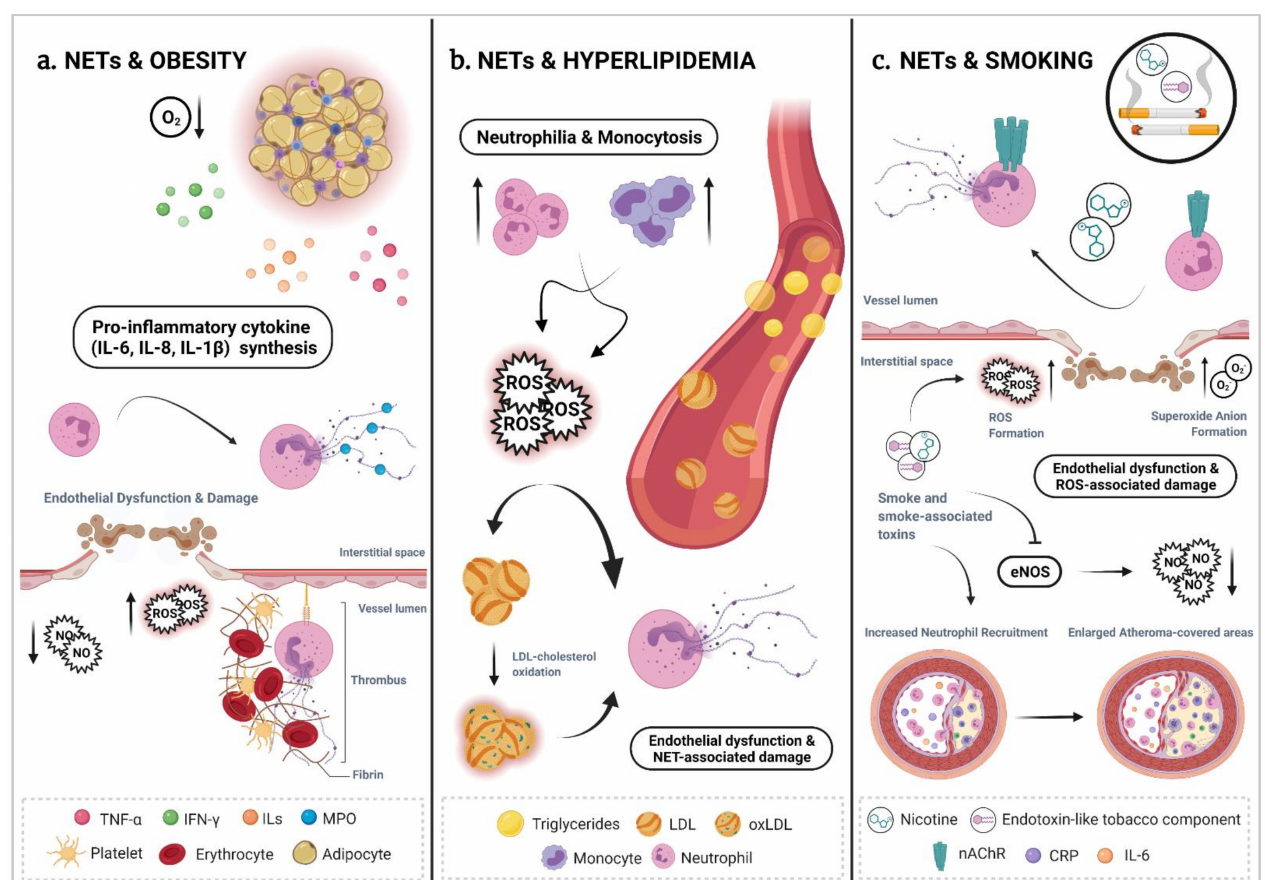
Figure 2. Proposed neutrophil extracellular traps mechanisms of action associated to some cardiovascular and lifestyle- derived risk factors. ( a ) In an obese context, excessive accumulation of white adipose tissue (WAT) appears to be depleted of physiological oxygen levels and is associated to a systemic and chronic low-grade inflammatory profile. Hypoxia in WAT induces necrosis, immune cell infiltration, oxidative stress and a general overproduction of pro-inflammatory cytokines. This scenario facilitates “obese” neutrophils to undergo spontaneous NETosis. Augmented neutrophil extracellular traps (NET) levels have also been associated to an increased number of thromboembolic events in obese patients due to the NET-mediated endothelial damage and dysfunction. ( b ) Hyperlipidemia reflects a status of elevated levels of lipids —such as cholesterol and triglycerides— in the blood. Hypercholesterolemia triggers monocytosis and neutrophilia, conditions that are associated with the release of pro-inflammatory cytokines and the production of oxidative stress. Deposited cholesterol crystals and oxidized LDL particles can function as sterile danger signals that induce the release of NETs, contributing so to endothelial dysfunction and NET-associated damage. Cholesterol crystal-triggered NETs can prompt the NLRP3 inflammasome activation in primed lesional macrophages, and arouse them into releasing inflammatory cytokines such as IL-1ß and IL-18, which will further amplify immune cell recruitment, and, in turn, increment NETosis ratios. ( c ) Cigarette smoke impairs nitric oxide-mediated endothelial function and elicits cardiovascular toxicity due to augmented ROS and superoxide anions (O 2 − ) generation. Smoker subjects display elevated levels of pro-inflammatory markers such as IL-6 or CRP, both recognized players in atherosclerosis. NETs have been proposed now to play a main role in this context. Neutrophils are able to undergo NETosis via the stimulation of the nicotinic acetylcholine receptor in response to nicotine stimulation. Cigarette smoke, nicotine, and cigarette-associated toxins are able to exacerbate inflammatory pathways, induce tissue damage and enlarge atheroma-covered areas in the arterial wall in an atherosclerotic context, all due to an increased NET formation capacity. Figure legend: ROS (reactive oxygen species), NO (nitric oxide), nAChR (nicotinic acetylcholine receptor), eNOS (endothelial nitric oxide synthase), CRP (C-reactive protein). Created with